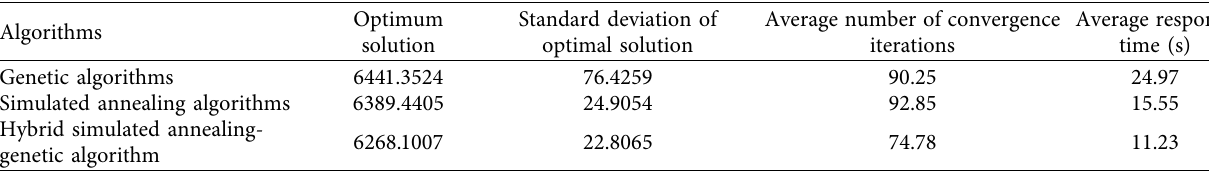
Table 7: Comparison of results of simulation experiments.